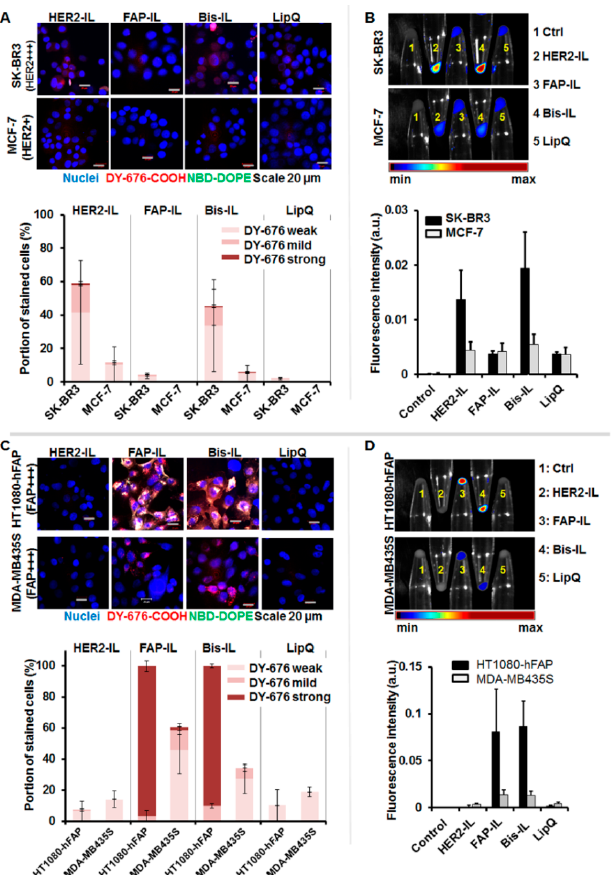
Figure 4. Confocal microscopy and NIRF analyses of liposomal cargo release in HER2 and FAP-expressing cells. Cells were incubated with 200 nmol of the indicated liposomes for 8 h at 37 °C. ( A ) Confocal microscopic images (scale bar 20 µm) and corresponding semiquantitation of the fluorescence intensities of the HER2 expressing cells reveal different levels of released/activated DY676-COOH in the cells (bars). This correlates with ( B ) the intensities of the DY676-COOH signals validated by macroscopic NIRF imaging of cell pellets. The Bi-FAP/HER2-IL (Bis-IL) and HER2-IL are taken up by SKBR3, whereas the FAP-IL and LipQ are not. ( C ) Confocal microscopic images (scale bar 20 µm) of FAP expressing cells reveal cells with different levels of released/activated DY676-COOH as determined by semiquantitation of the fluorescence intensities (bars). This correlated with the intensities of the DY676-COOH validated by macroscopic NIRF imaging of cell pellets ( D ). The Bi-FAP/HER2-IL (Bis-IL) and FAP-IL are selectively taken up by the cells, whereas the HER2-IL and LipQ are not taken up by the FAP-expressing cells. Each bar depicts the mean of three independent tests and the standard deviations.